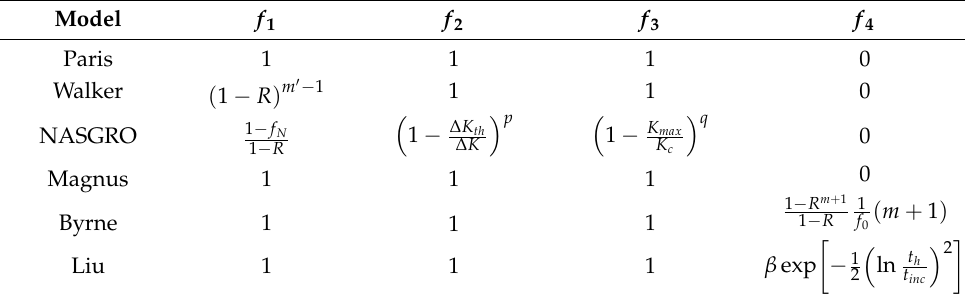
Table 3. Crack growth models summarized in a unified format of Equation (10).